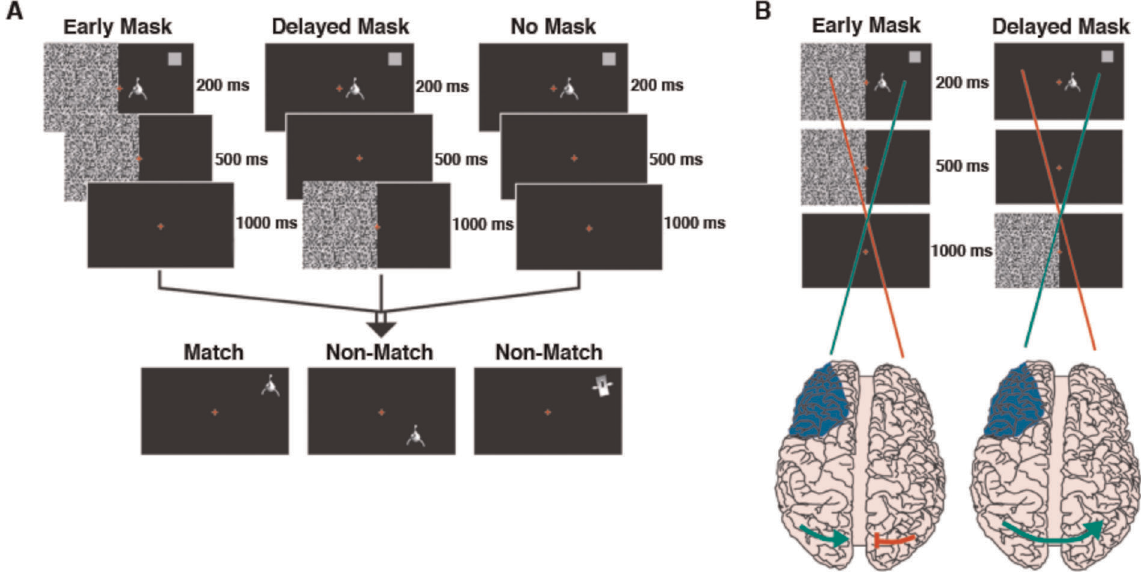
Figure 2. Behavioral Paradigm. ( A ) In all three conditions (early mask, delayed mask, and no mask) subjects were presented with an unidentifiable, non-verbalizable, black and white object and a gray location cue (see Materials and Methods for details). ( B ) Schematic of the main hypothesis. In the early mask condition, the mask adds noise during the processing of the visual object and spatial cue by the non-lesioned hemisphere, reducing the fidelity of the transcallosal transfer of visual information (disconnected green/red line over visual cortex). In the delayed mask condition, however, task-relevant visual information crosses the corpus callosum before the mask appears, allowing the non-lesioned hemisphere to assist in object-spatial recognition (intact green line over visual cortex). Blue shading illustrates the location of the subjects’ lesions. doi:10.1371/journal.pone.0034937.g002 PLoS ONE |